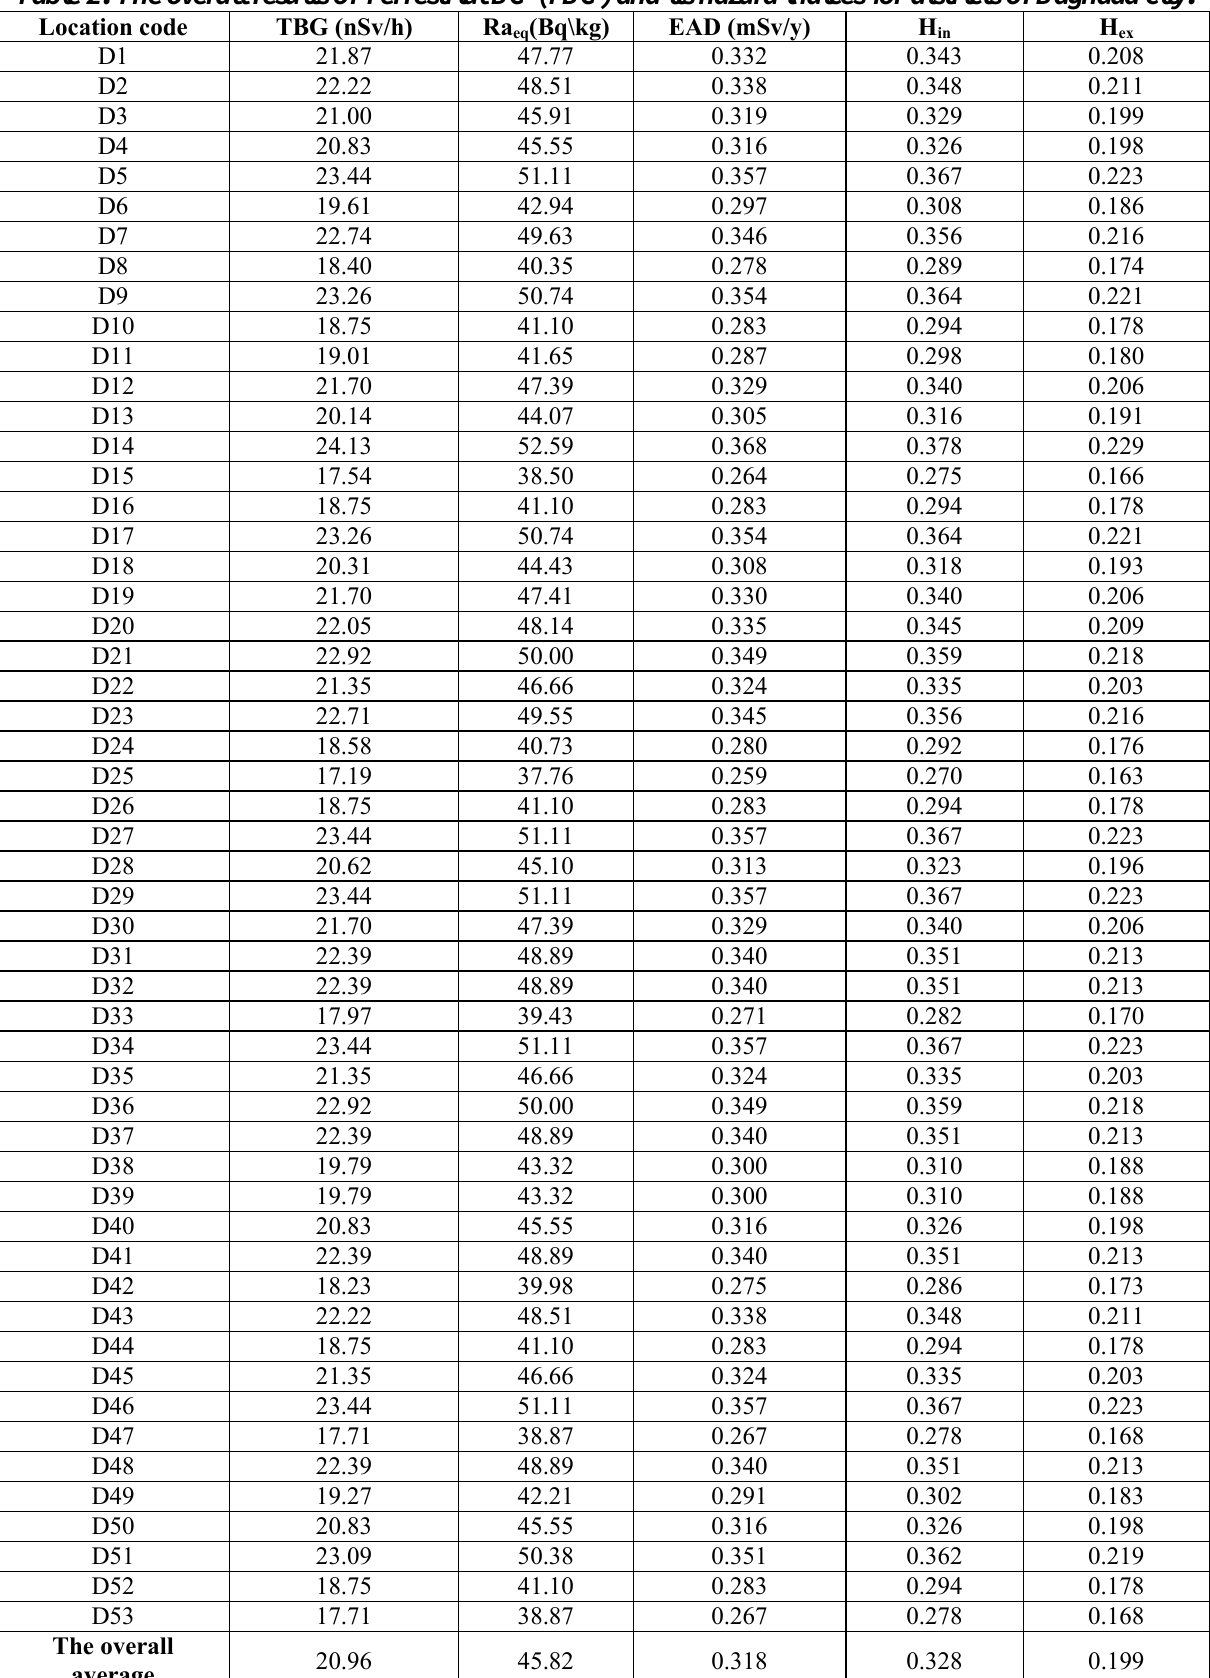
Table 2: The overall results of Terrestrial BG (TBG) and its hazard indices for districts of Baghdad city. Location